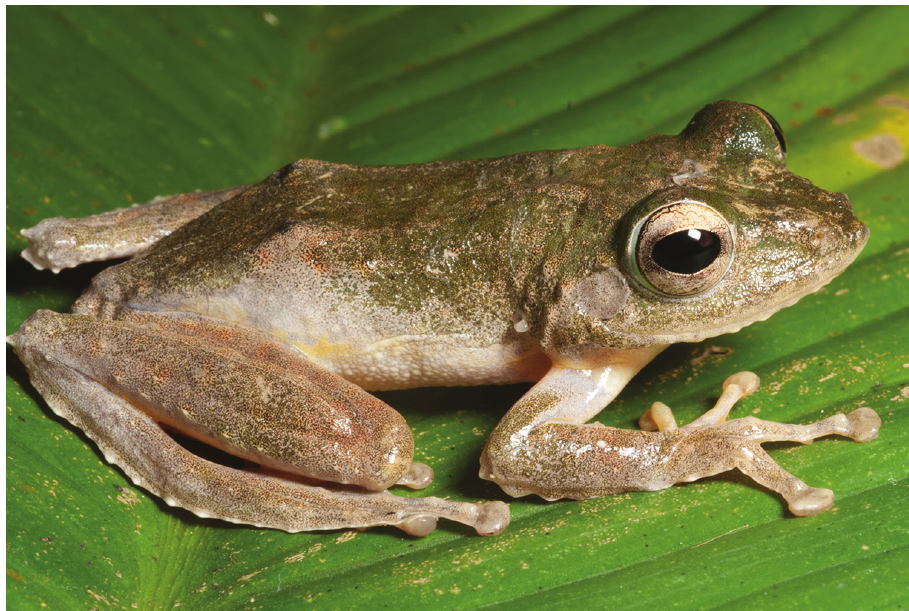
Figure 35. Kurixalus appendiculatus has been recorded in Agusan del Sur, Camiguin, and Misamis Oriental provinces (Fig. 1). Photo: RMB (from the Municipality of Balangiga, Samar; specimen deposited at